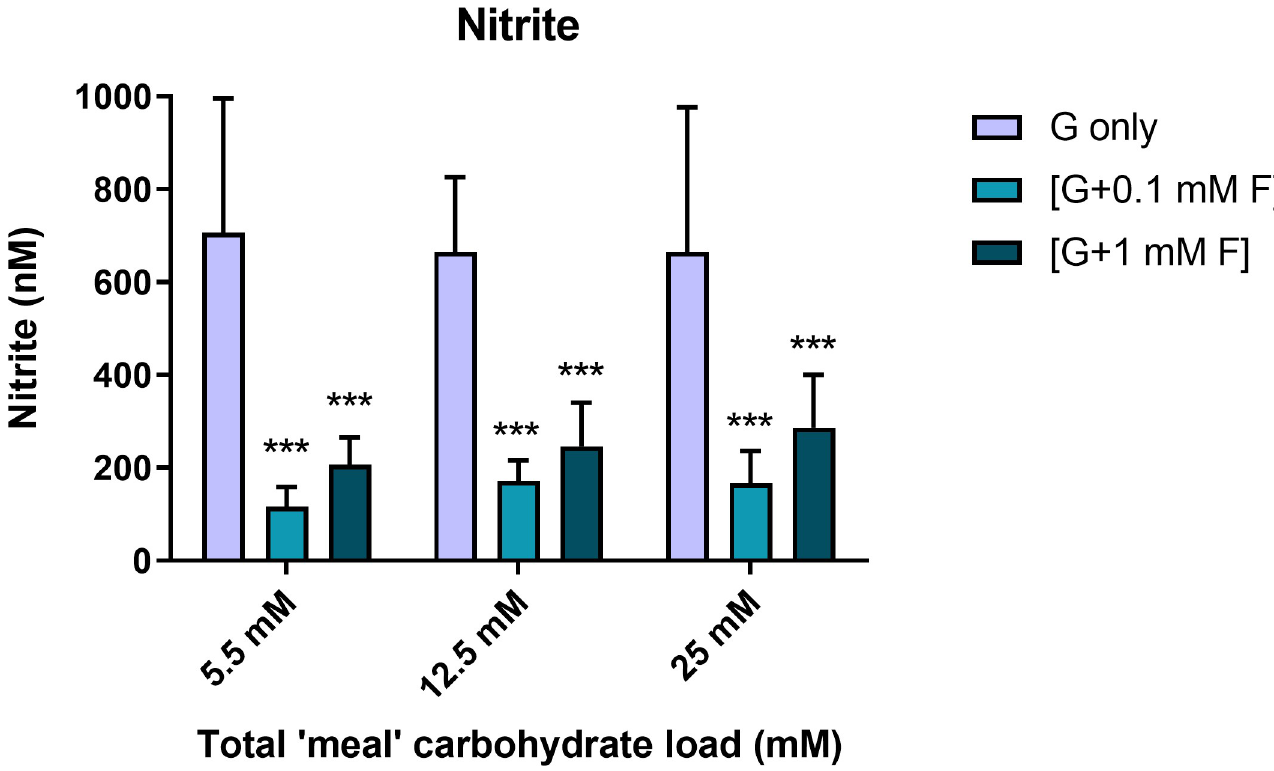
Fig 2. Nitrite accumulation as a surrogate for NO generation. Effect of intermittent glucose and glucose/fructose exposure on nitrite accumulation at NG, IG and HG test conditions (n = 12–14; ��� P < 0.001 Bonferroni post-test compared to glucose only control at equivalent concentrations).